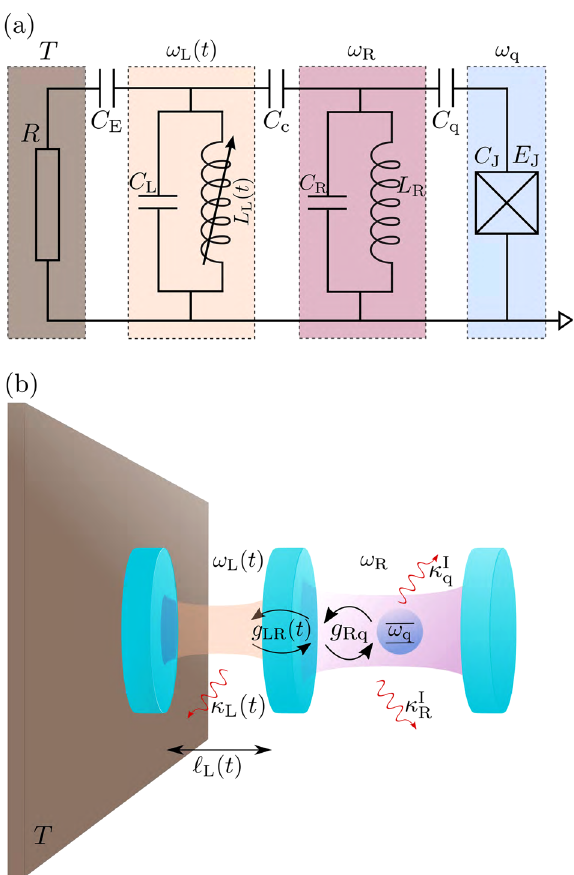
Fig. 1 Schematic qubit initialization set-up. a Lumped-element circuit model. A superconducting qubit ( blue box ) with angular is indirectly coupled to frequency ω q and intrinsic relaxation rate κ I q a thermal bath ( brown ), formed by a resistor R , through two LC resonators. By tuning the inductance L L ( t ) of the left resonator ( orange ), one can tune its bare resonance frequency and coupling strengths g LR ( t ) and κ L ( t ) with the right resonator ( magenta ) and the bath (temperature T ), respectively. The right resonator has a bare angular frequency of ω R and is coupled to the qubit and an intrinsic bath with coupling strengths g Rq and κ I . ( b ) Analogous cavity R quantum electrodynamics (QED) set-up where a two-level atom is coupled to a thermal bath through two optical cavities. The coupling to the thermal bath is controlled by tuning the length ‘ L ð t Þ of the left